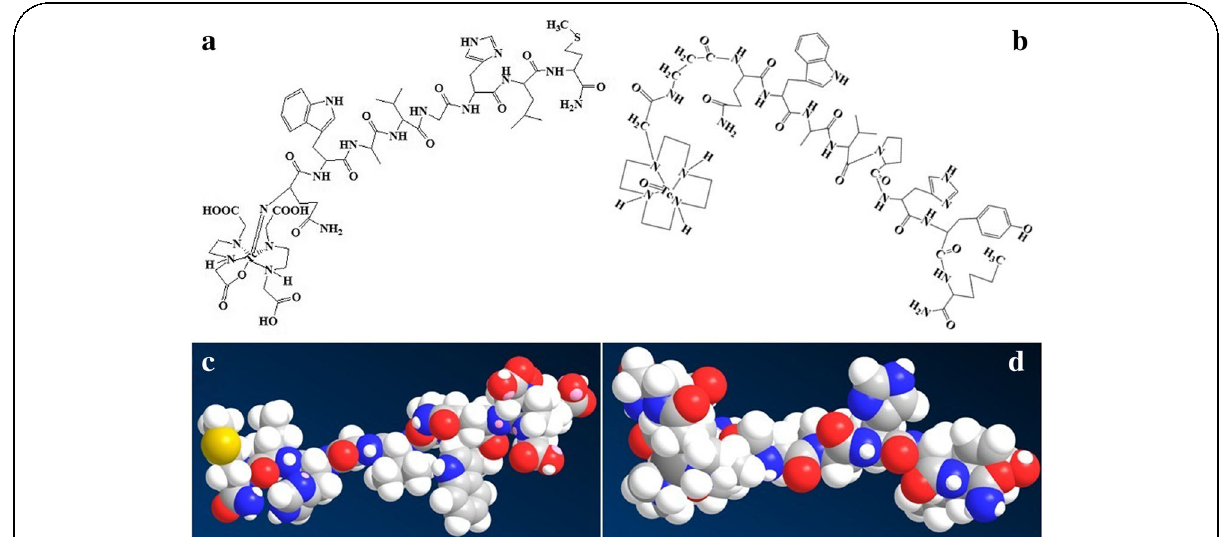
Fig. 2 Chemical structure of 99m Tc-labeled BNS ( a ) and 99m Tc-labeled BN4 ( b ) with the MM2 energy minimized probable molecular structure of 99m Tc-BNS ( c ) and 99m Tc-BN4 ( d